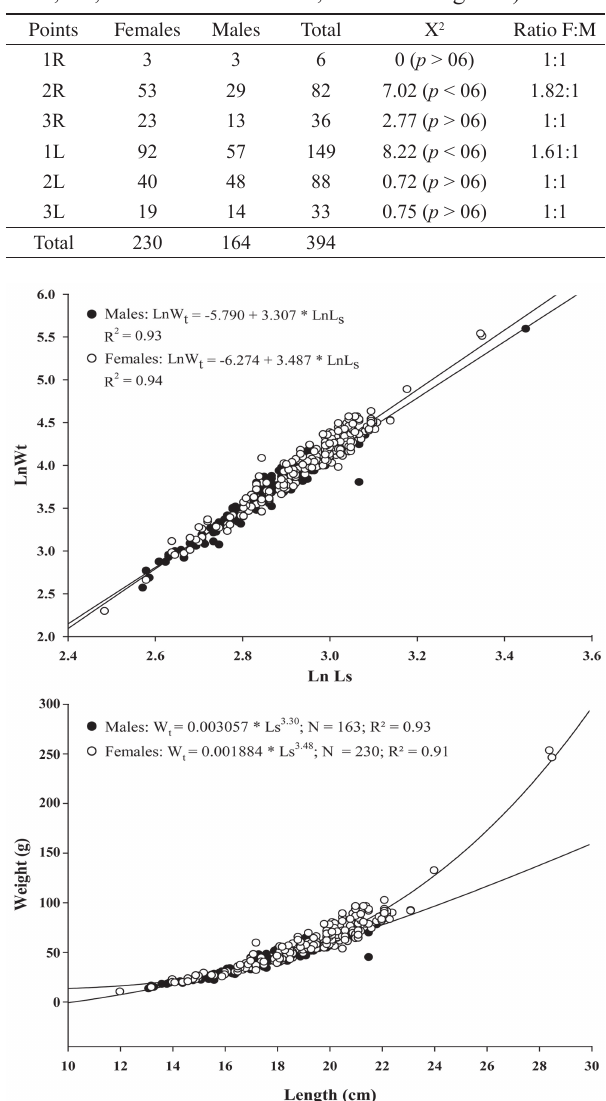
Table 2. Distribution by sampling points and their respective sex ratios for Loricariichthys melanocheilus in the rio Ibicuí, Rio Grande do Sul. (1R, 2R and 3R = Points 1, 2 and 3 in the river; 1L, 2L and 3L = Points 1, 2 and 3 in lagoons).